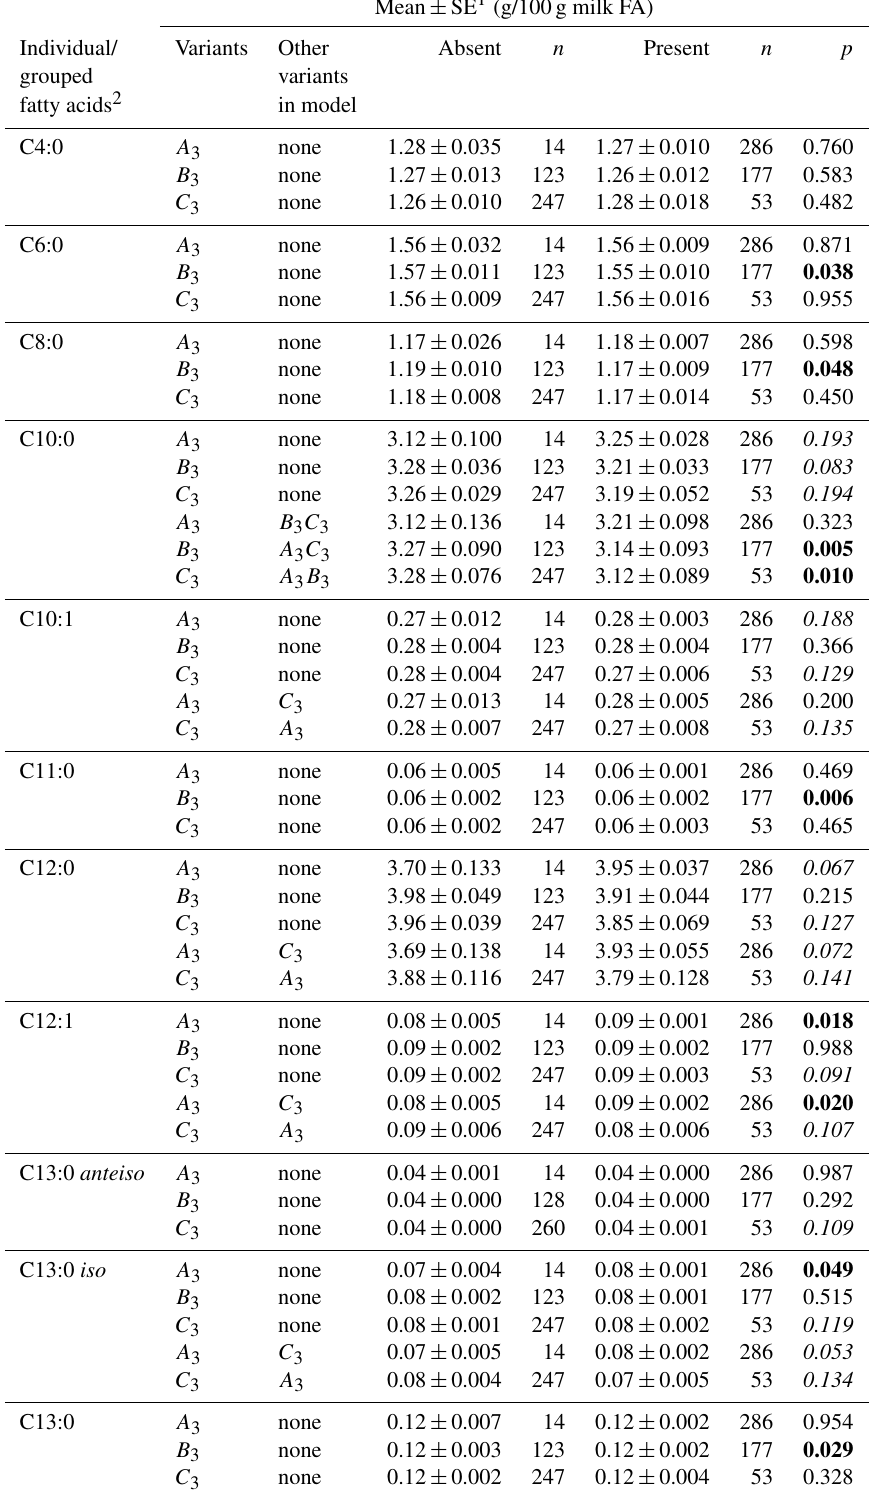
Table 1. Associations between bovine leptin gene variants with average quantity of individual and grouped milk fatty acid methyl ester (FAME) in New Zealand (NZ) HF × J